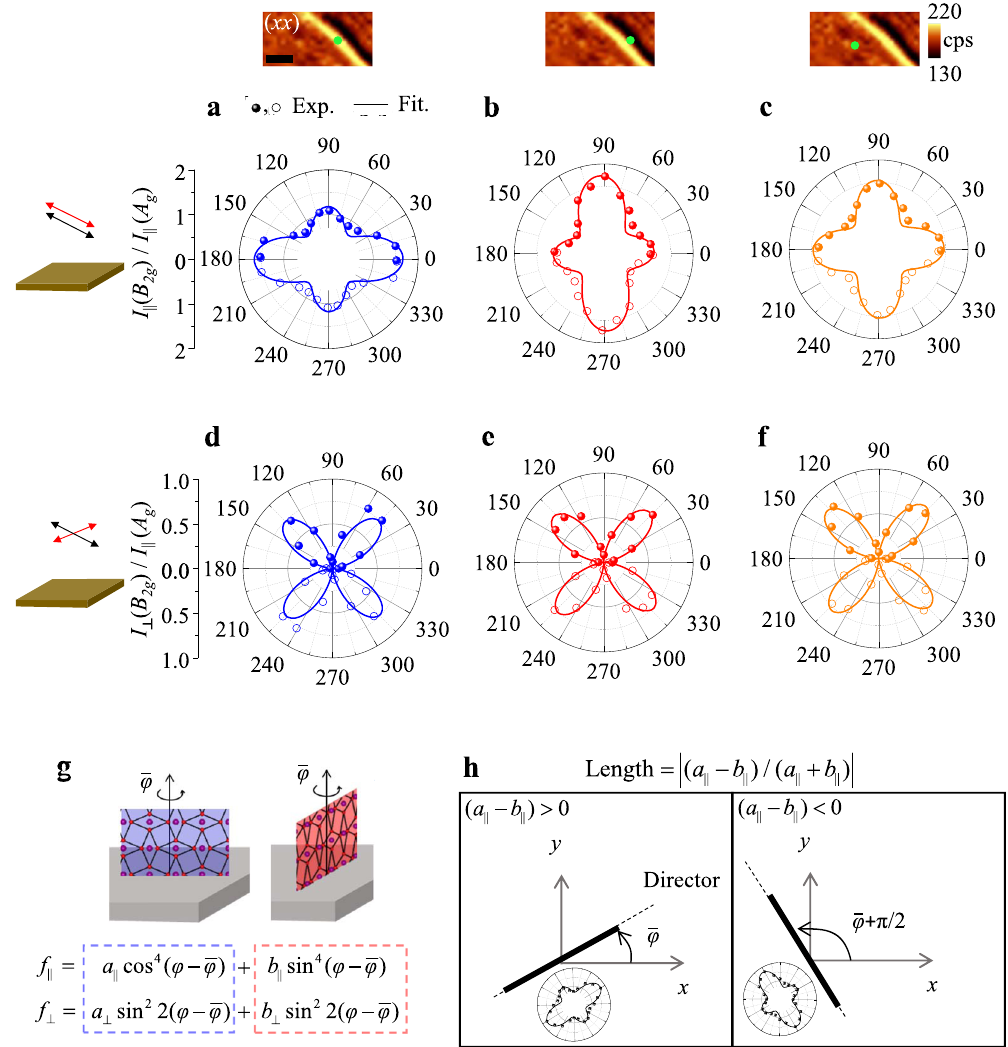
Fig. 3 Experimental results of the Raman intensities. a – f Polar plots of the Raman intensities of the B 2g mode normalized by that of the A g mode at three different positions, marked in the Raman maps above the corresponding graphs. The Raman maps were obtained at ~ 610 cm − 1 in the ( xx ) polarization con fi guration. The polar plots measured in the parallel ( a – c ) and cross ( d – f ) polarization geometries are displayed. The solid circles from 0° to 180° are experimental data, and the empty circles from 180° to 360° are the repetition of the data from 0° to 180° in order to construct the polar diagram. g The fi tting functions consist of two planes perpendicular to each other. The blue (red)-boxed terms indicate (010) C ((100) C )-oriented JT planes, as displayed in the schematics above the formula. h The de fi nition of the director, which is parallel to the JT planes. Scale bar in the Raman map is 1 μ